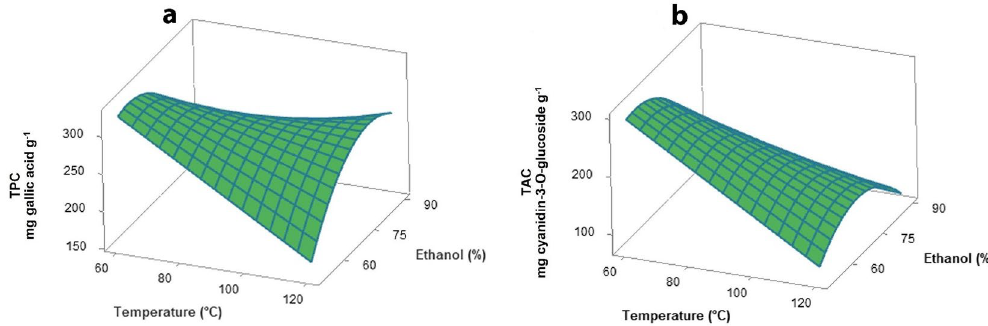
Figure 3. Response surface plots as a function of temperature and ethanol concentration on the total phenolic content ( a ), and total anthocyanin content ( b ).